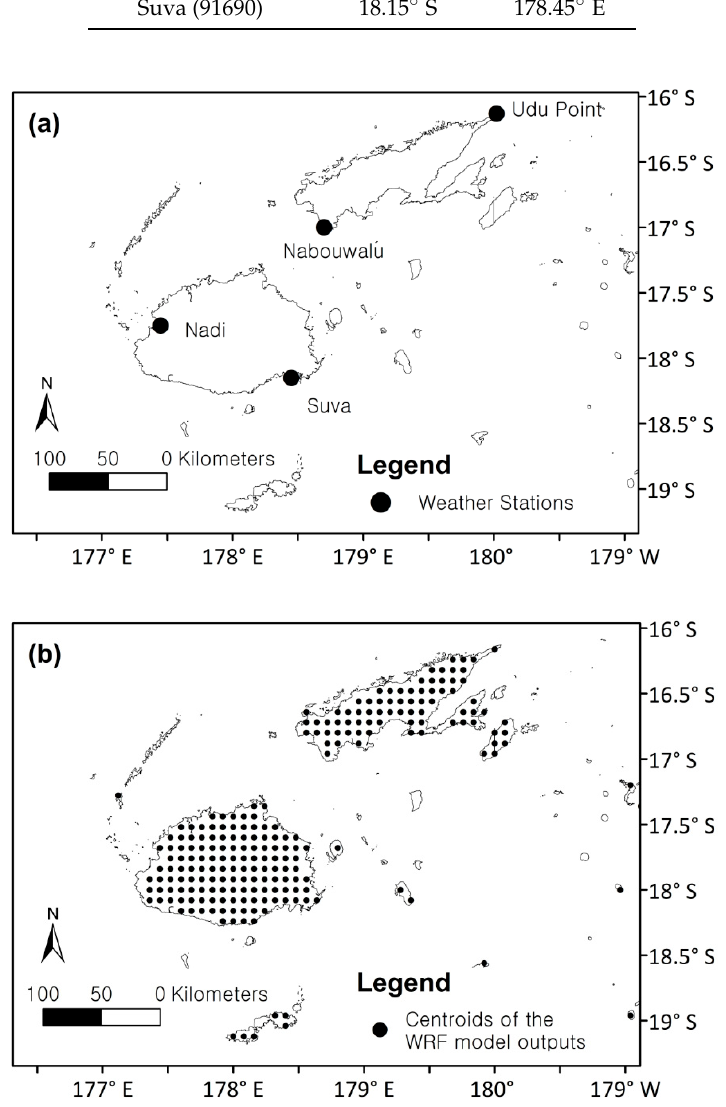
Figure 2. Location of ( a ) the rainfall gauges; and ( b ) the centroids of the Weather Research and Forecasting (WRF) model outputs.